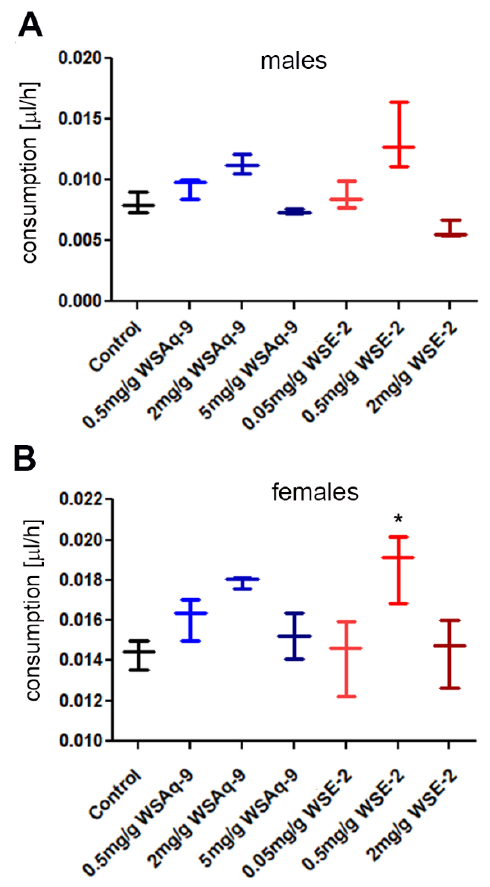
Figure 2. Food intake is not reduced by supplementation with WSAq-9 or WSE-2. ( A ) Males show no significant change in intake at any concentration of WSAq-9 or WSE-2. ( B ) Females also showed no change in intake of the supplemented food, with the exception of WSE-2 at 0.5 mg/g which was consumed slightly more. A D’Agostino and Pearson omnibus test showed that the data were not normally distributed, and the significance was then determined by Mann–Whitney tests comparing supplemented food to the control. Three independent measurements with 5 flies each were performed. The horizontal bars in the box plots represent the medians, boxes the 25% and 75% quartiles, and whiskers the max. and min. values. * p < 0.05.